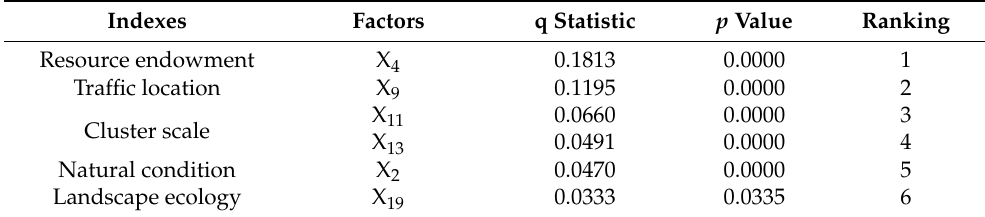
Table 5. Results of factor